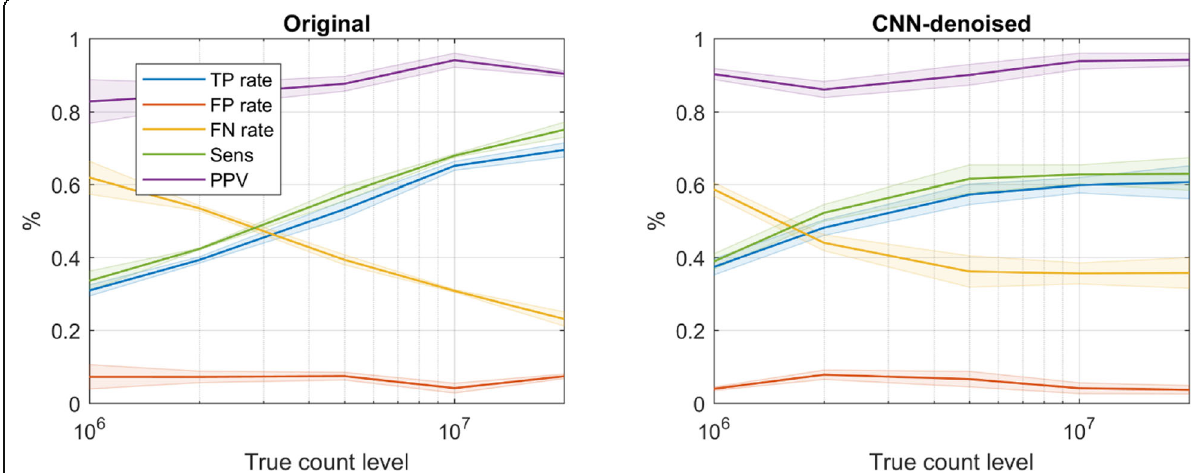
Fig. 7 Lesion detection performance for all 3 readers. In the lowest count levels, CNN-denoising improved detection, but this offered limited benefit at higher count levels, and the original smoothed images actually yielded better performance. The observer mean is given by the solid lines, and the inter-observer standard deviation is shown by the shaded regions